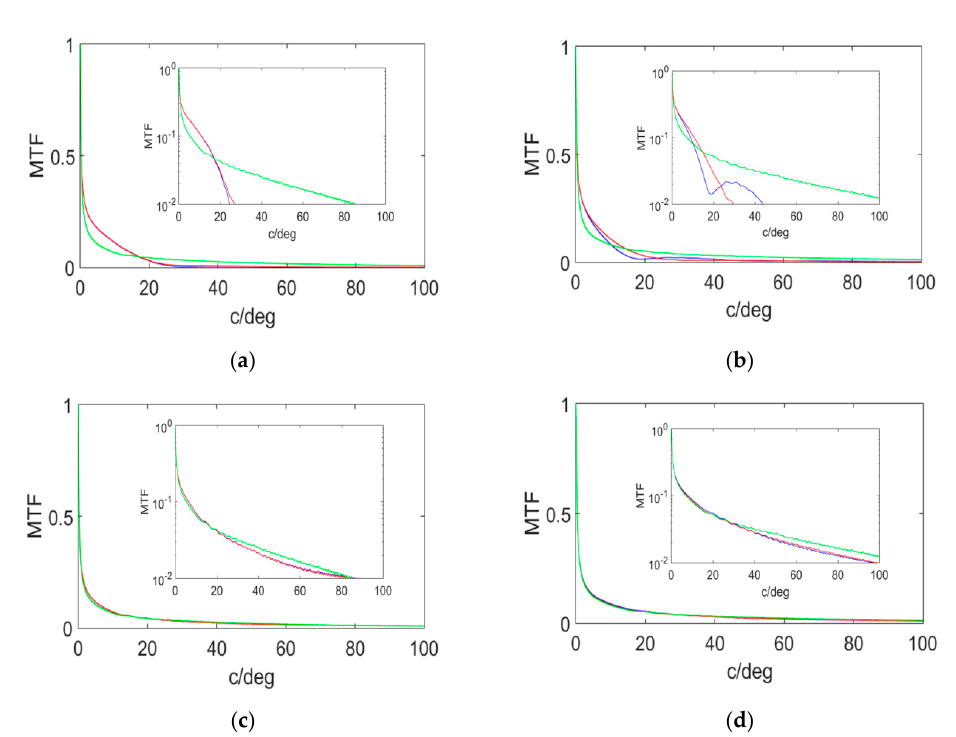
Figure 7. Simulated modulation transfer function (MTFs) for positive symmetrical ( a ) and ( b ), and negative asymmetrical ( c ) and ( d ); HLs reconstructed at 633 nm ( a ) and ( c ), and at 473 nm ( b ) and ( d ). A cut in x (red), cut in y (blue), and limited by di ff raction (green). A zoom of these curves at a limiting resolution of 0.01 is